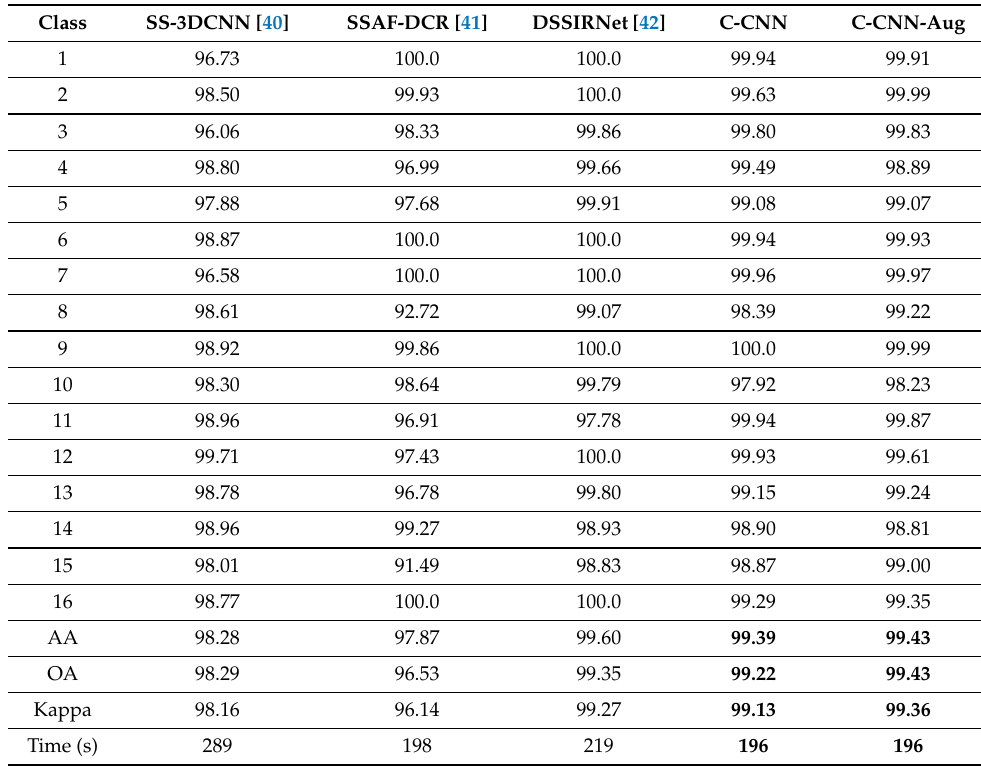
Table 6. The accuracy comparison of Salinas Scene classification.